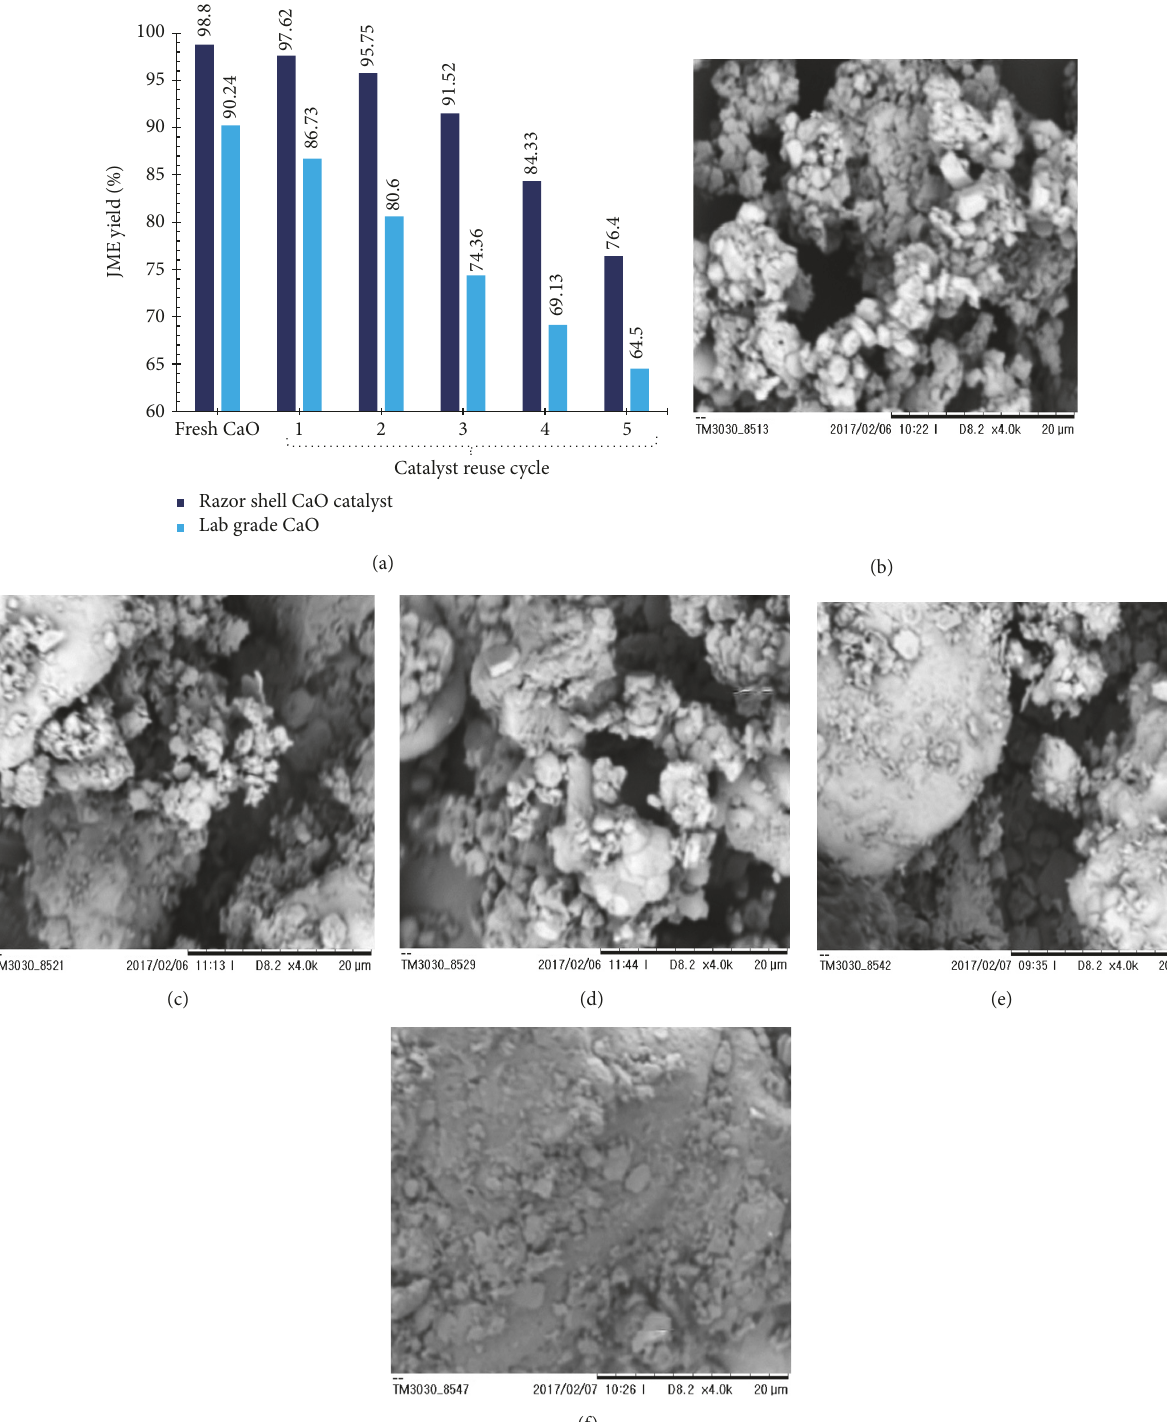
Figure 10: (a) JME yield study over Razor shell CaO and lab grade CaO catalysts reuse at optimal transesterification reaction conditions. (b–f) SEM images of Razor shell CaO catalyst presenting catalyst surface structure variations after